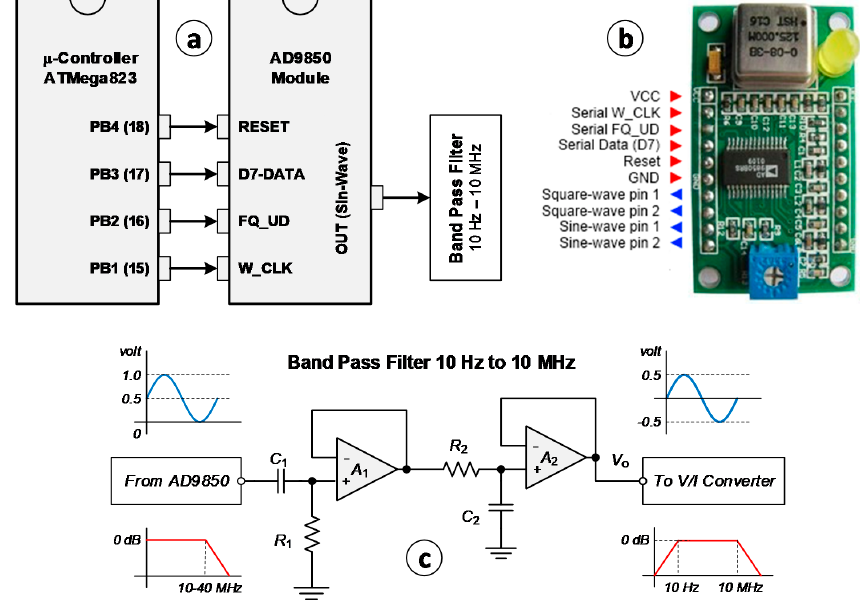
Figure 2. AD9850-based voltage generator module with frequency range of 10 Hz to 10 MHz.